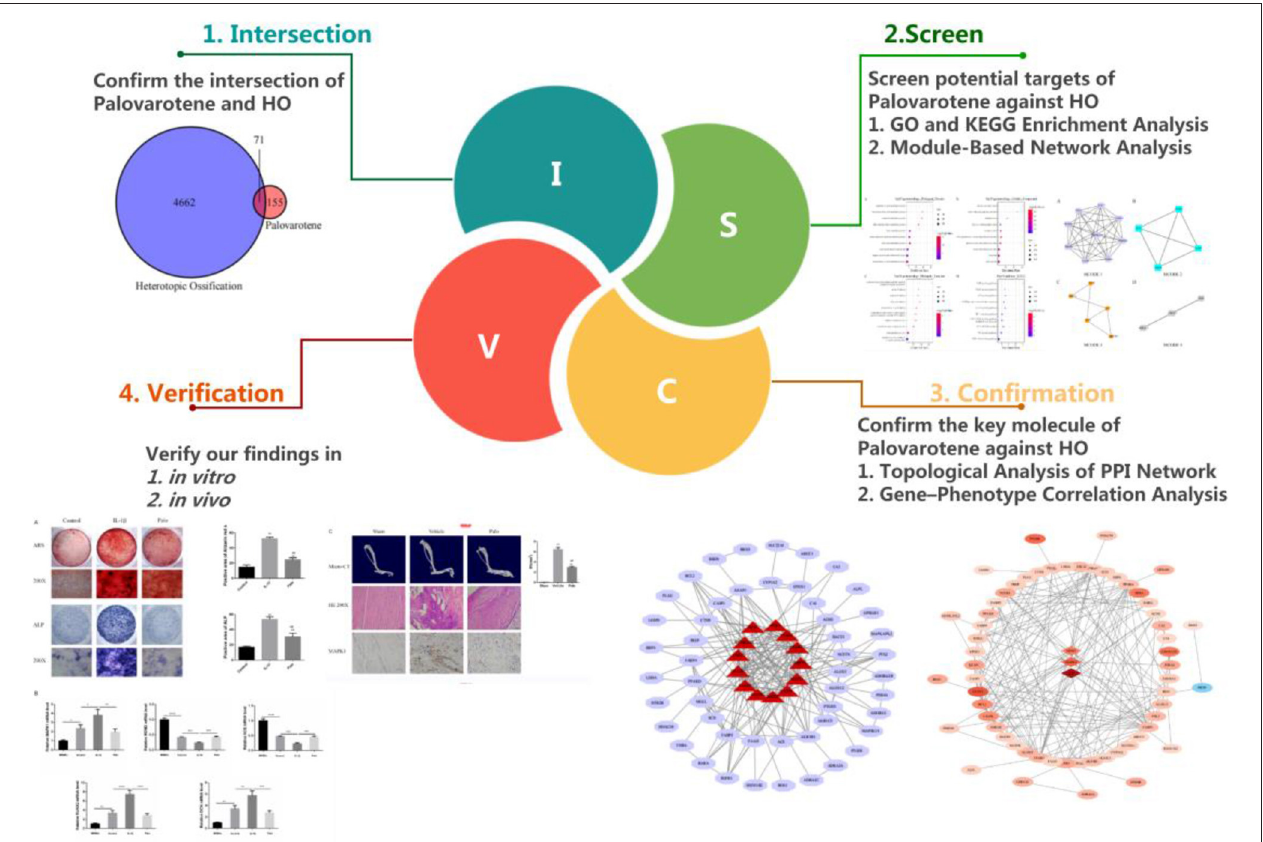
FIGURE 1 | Workflow diagram of